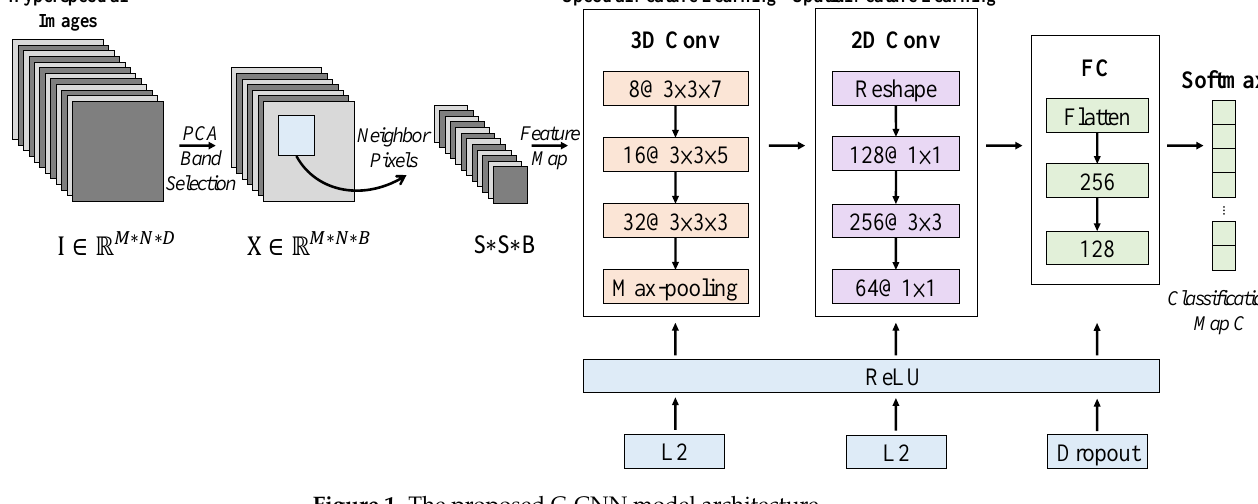
Figure 1. The proposed C-CNN model